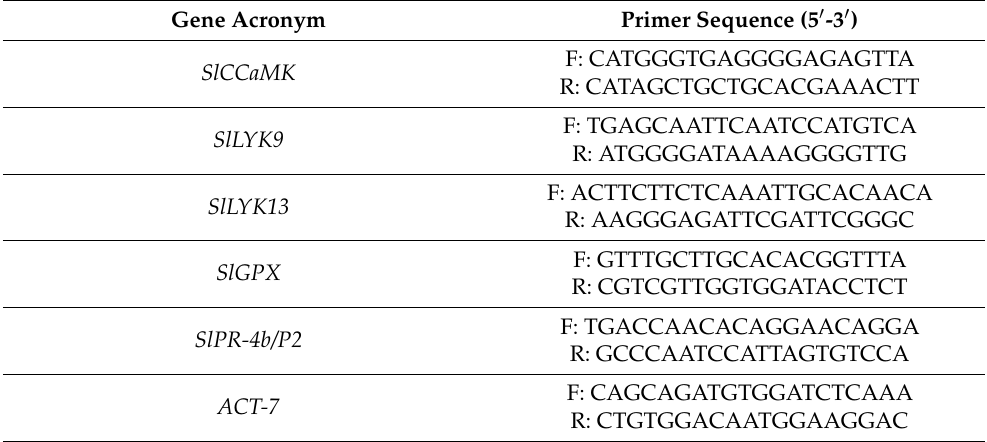
Table 2. Tomato AMF colonization- and defense-related genes examined in this study and the specific primers used in quantitative reverse transcriptase-polymerase chain reaction (qRT-PCR). Gene Acronym Primer Sequence (5 (cid:48) -3 (cid:48) )